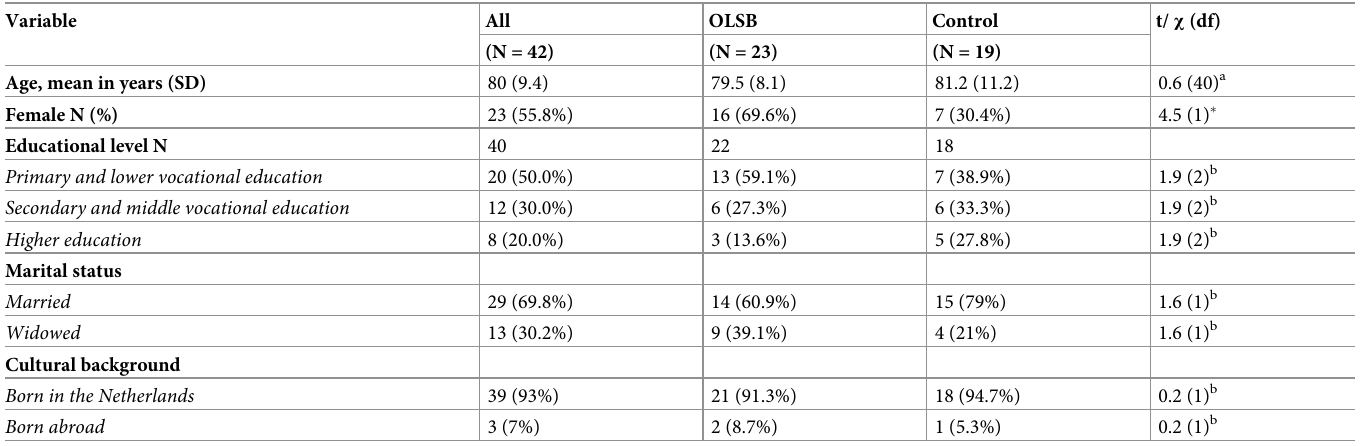
Table 1. Demographical data and personal information of persons with dementia at baseline.